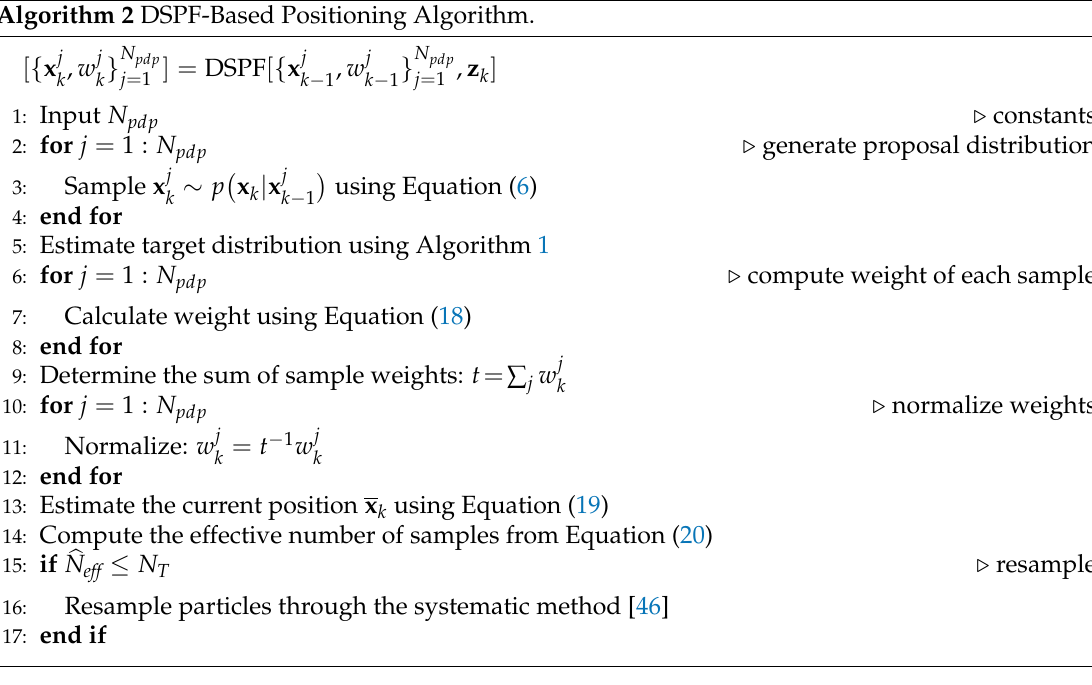
Algorithm 2 DSPF-Based Positioning